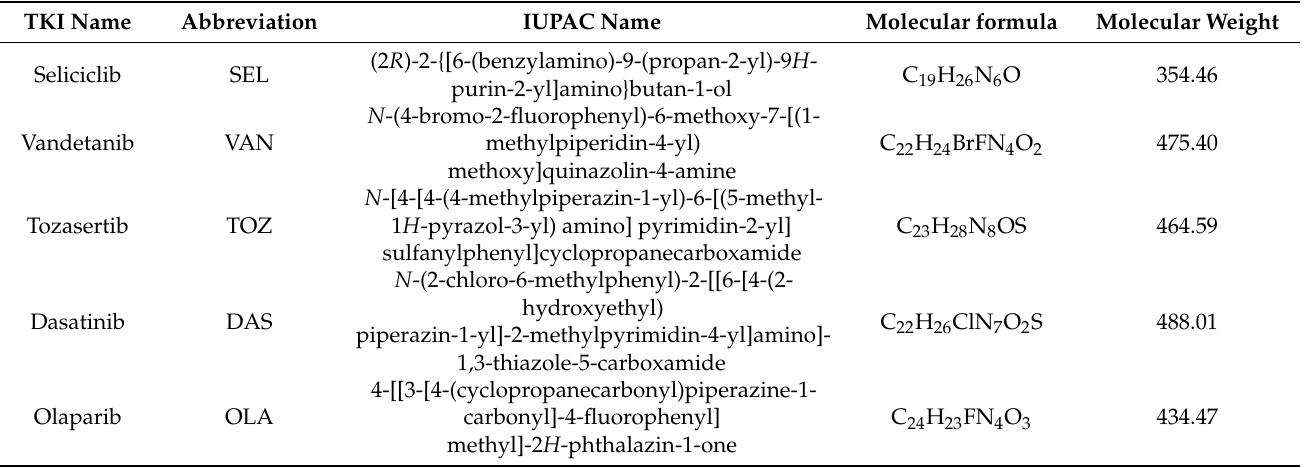
Figure 1. The chemical structures of chloranilic acid (CLA) and the investigated tyrosine kinase inhibitors (TKIs) with their abbreviations. Asterisks symbol (*) denotes the electron-donating sites of interactions of TKIs with CLA and the charge-transfer complexes (CTCs) formed. Table 1. The investigated TKIs with names, abbreviations, IUPAC names, molecular formulae and molecular